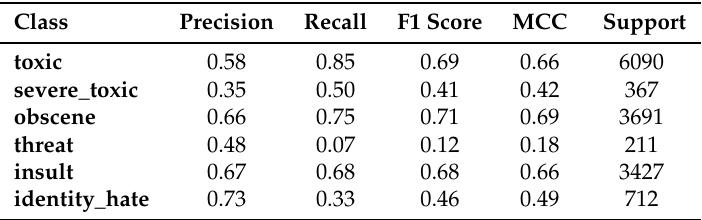
Table 14. Results of the individual toxicity classes of biLSTM + CNN model with custom-trained word2vec embeddings without standard pre-processing. Class Precision Recall